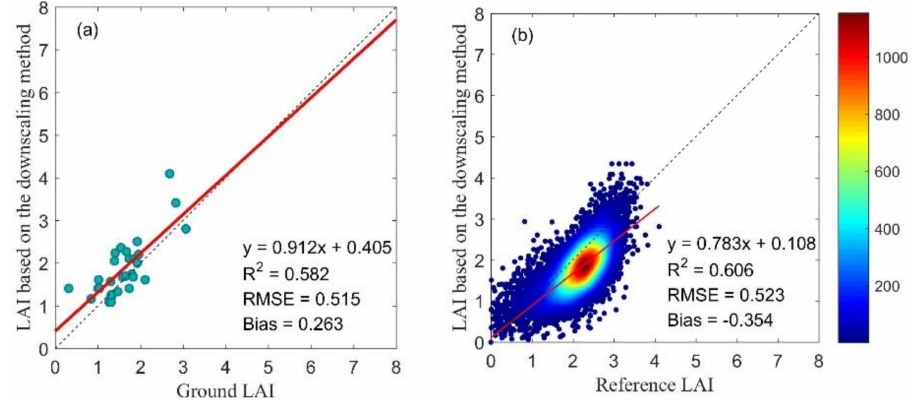
Figure 11. Evaluation of the fine-resolution LAI based on the model-downscaling method proposed in this paper at the Camerons site. ( a ) Ground LAI measurements. ( b ) Reference LAI map with 30 m spatial resolution obtained from the VAlidation of Land European Remote-Sensing Instruments (VALERI)